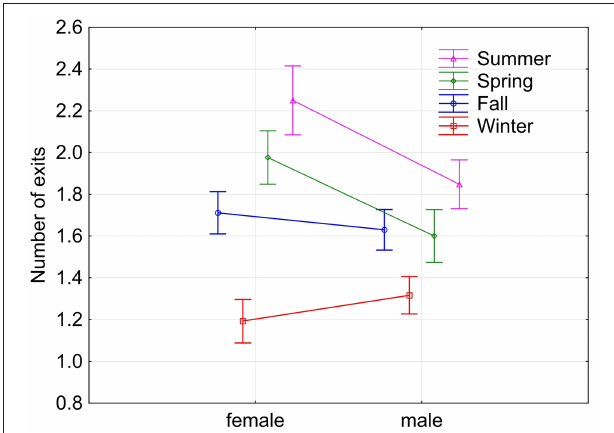
FIGURE 4 | Means (and 95% confidence intervals) of the number of exits by female and male squirrels during the four seasons. Current effect: F (3,1,344) = 9.2425, p <